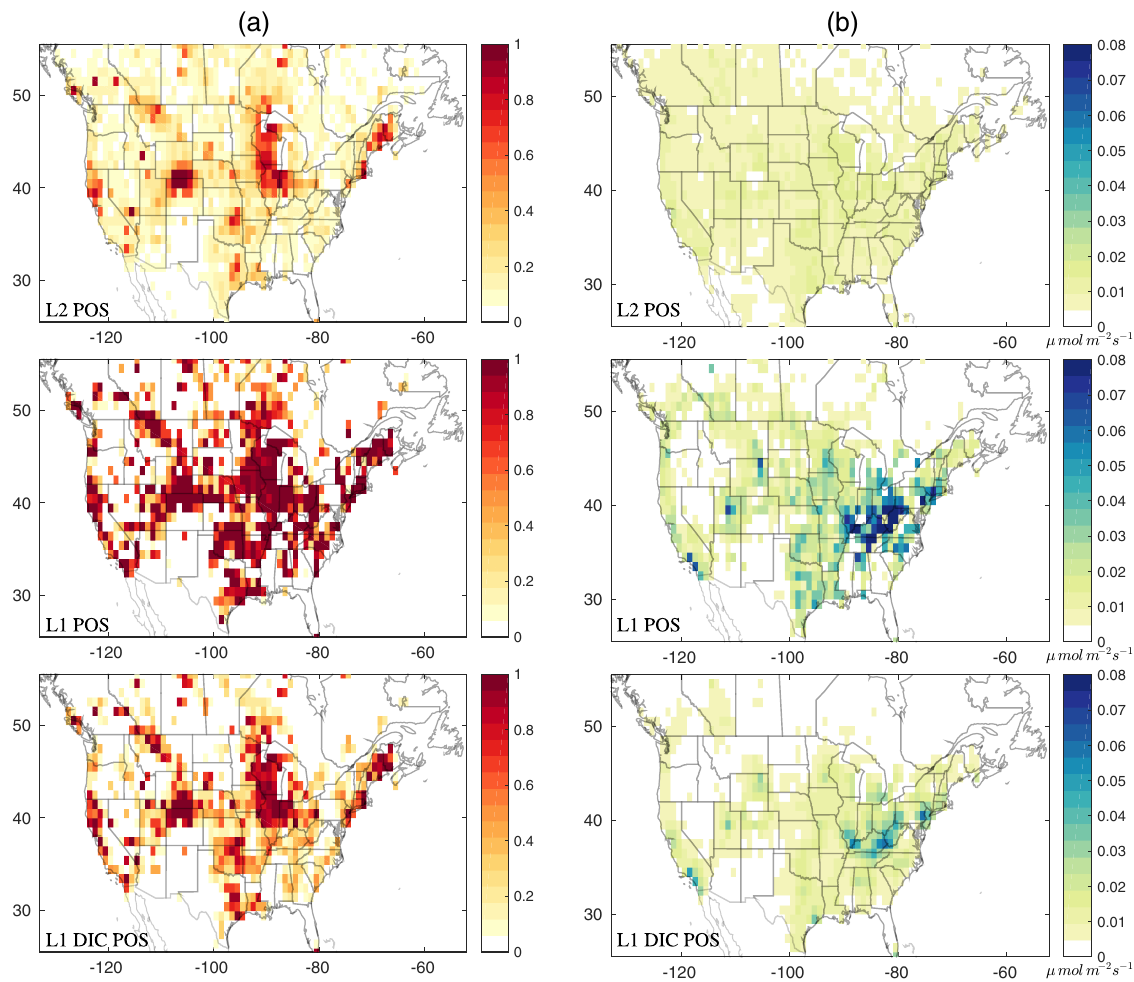
Figure 8. (a) Diagonal of the numerically calculated sensitivity matrices for large deviations of (cid:107) (cid:49)x k (cid:107)= 0.1µmolm − 2 s − 1 . (b) Two standard deviation uncertainties due to noise on the